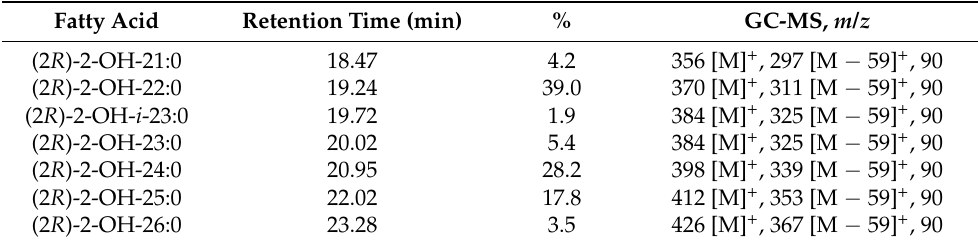
Table 4. Sphingoid base composition of the phytoceramides from M. clathrata *. Sphingoid % in RRT ** Base Fraction *** i -t17:0